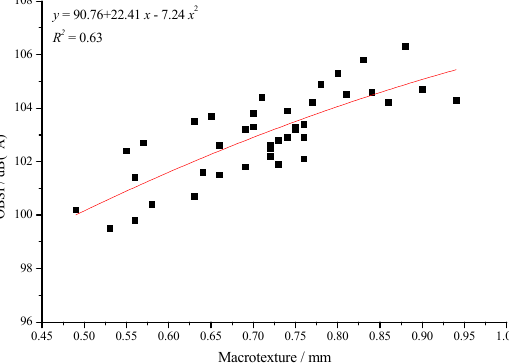
Figure 4. Regression analysis between macrotexture of transverse groove pavement and tire/road